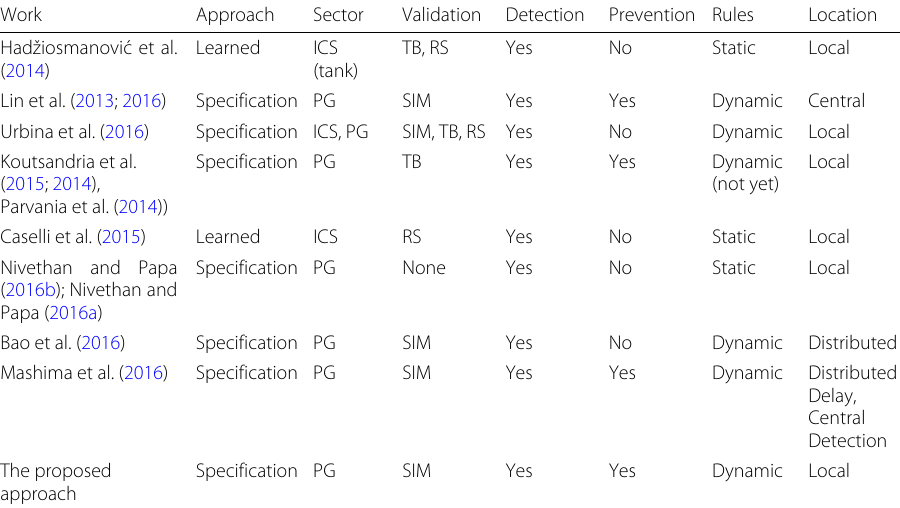
Table 6 Comparison of process-aware IDS